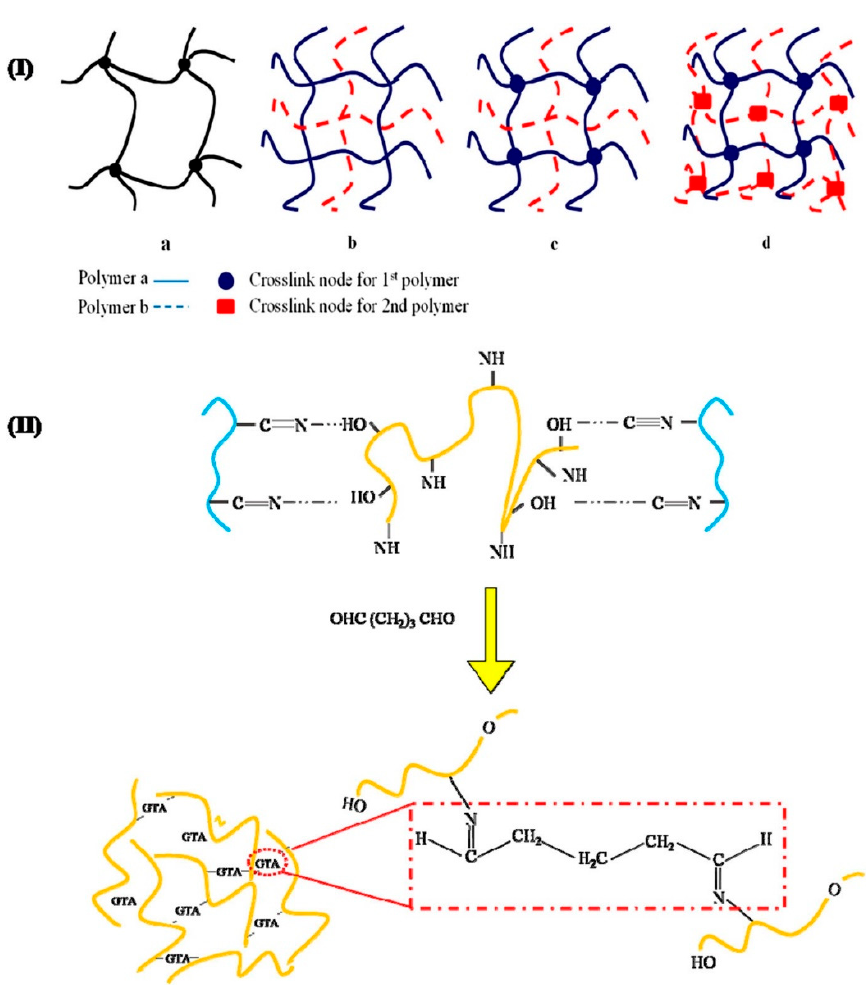
Figure 7. ( I ) Polymer hydrogels: ( a ) polymer network, ( b ) polymer blend, ( c ) sIPN, ( d ) full IPN, and ( II ) schematic representation of preparation of semi-IPN. Adapted with permission from reference [22]. Table 1. Performance overview of various polyacrylonitrile-based adsorbents. S. No.